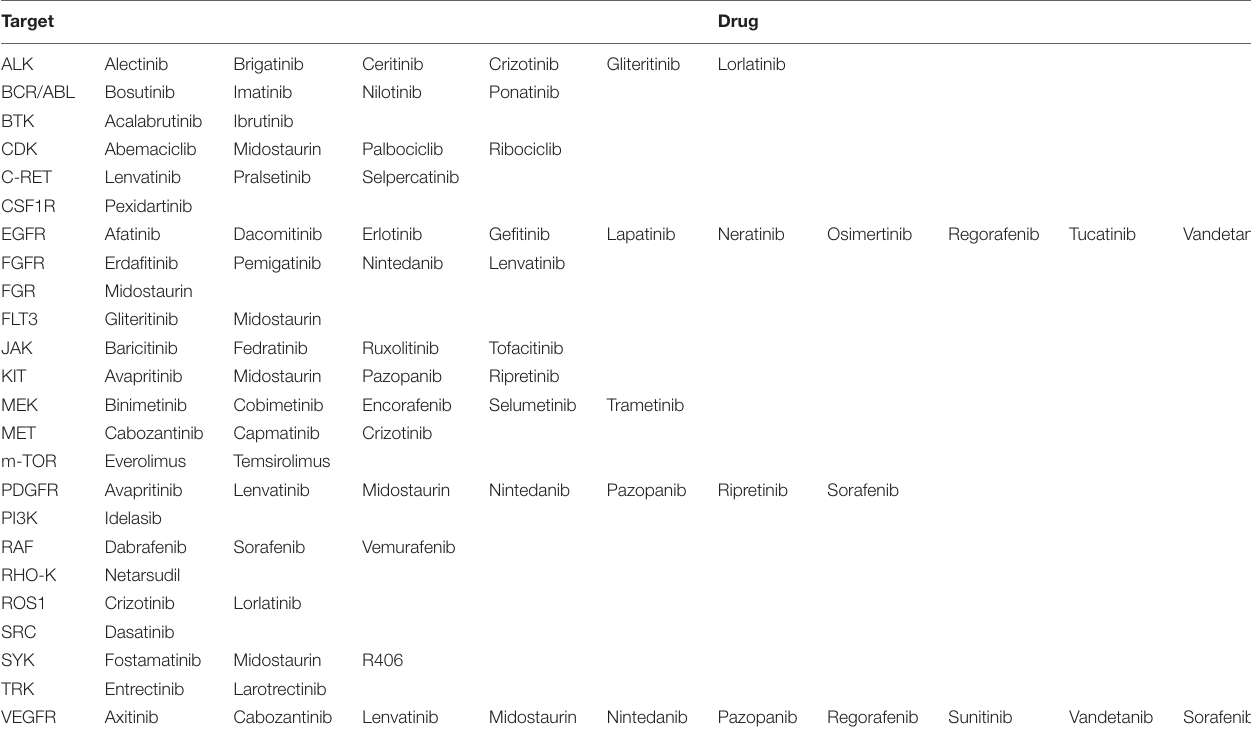
FIGURE 2 | Timeline of FDA approvals for kinase inhibitors. TABLE 1 | Protein kinase inhibitors and their related